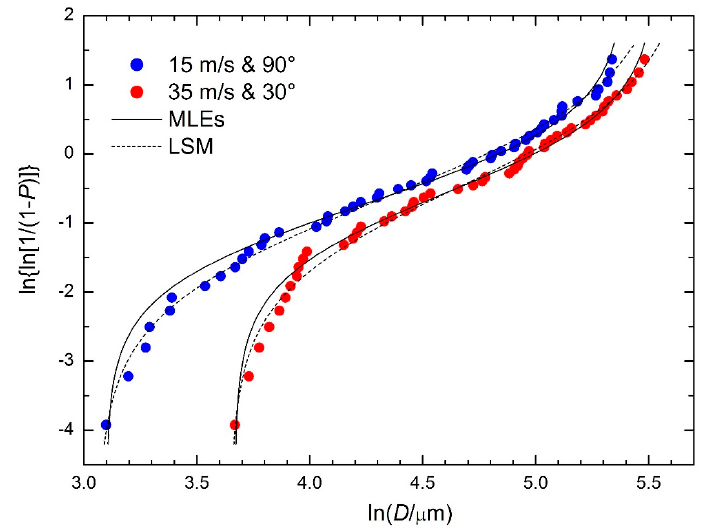
Figure 12. Weibull plots of defect sizes in soda lime glass due to the air stream with sand particles at given velocities and impact angles [15] with the distribution parameters determined by MLEs (solid lines) and by LSM (dashed lines). Table 2. Comparison of the values of the distribution parameters of defect sizes in soda lime glass due to the air stream with sand particles at given velocities and impact angles [15] determined by MLEs and by LSM (two Equations (3) and (4) for cumulative probability values were considered). Method → MLEs